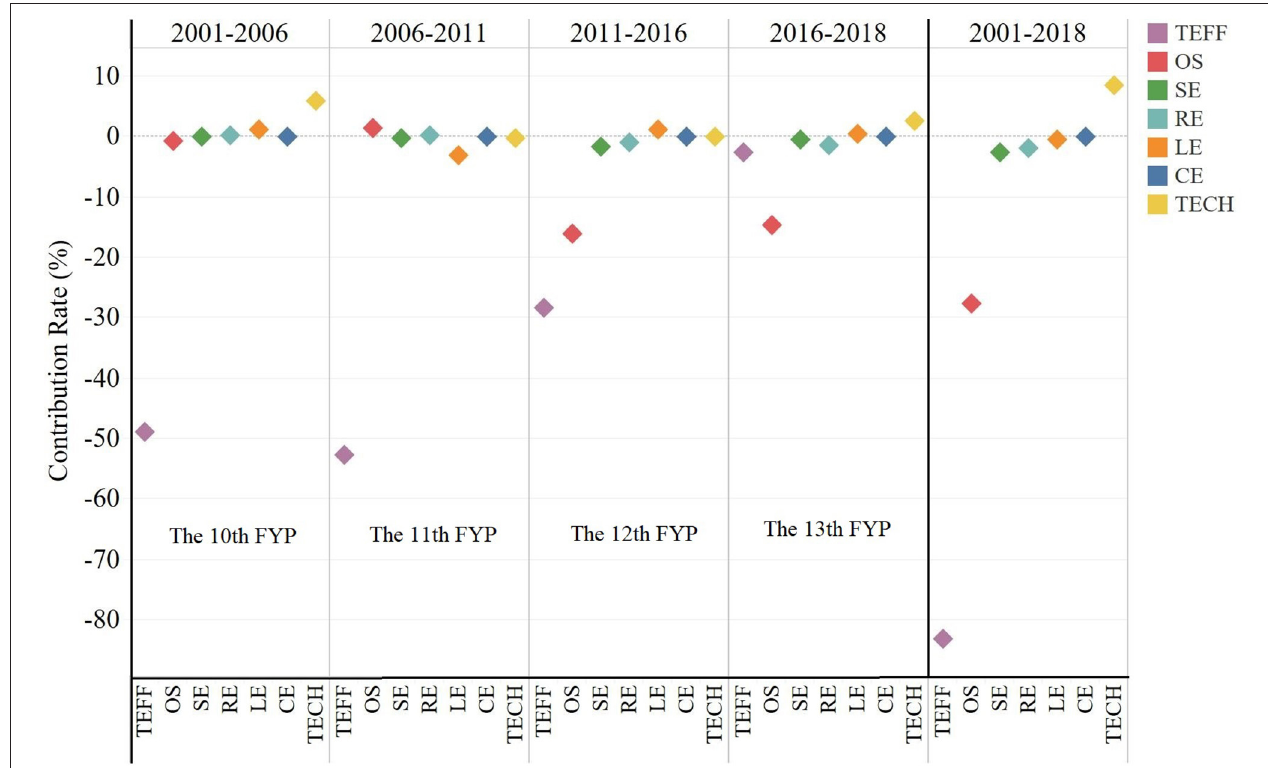
FIGURE 3 | Contribution rate of each driving factor in different periods at national